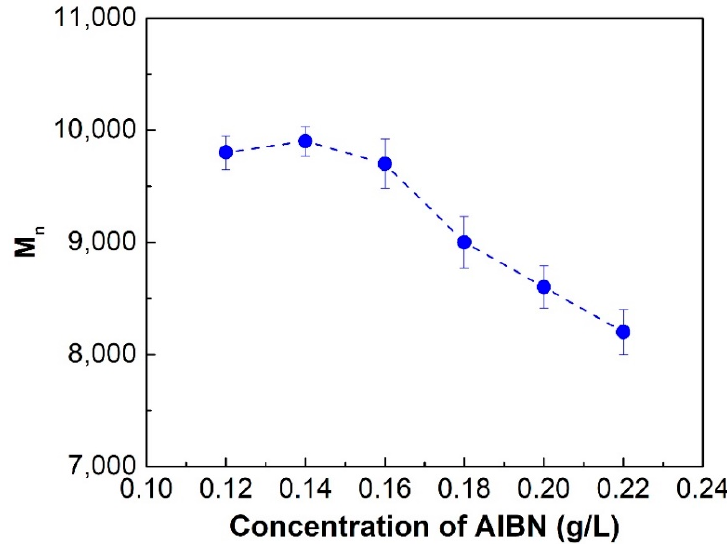
Figure 8. The effect of AIBN concentration on molecular weight of PAM. The plot of M n vs. polymerization time. Polymerization conditions: [M] 0 , 12%; [M] 0 /[CTA] 0 , 200/1; range of [AIBN], 0.12 to 0.22 g/L; temperature, 70 °C.